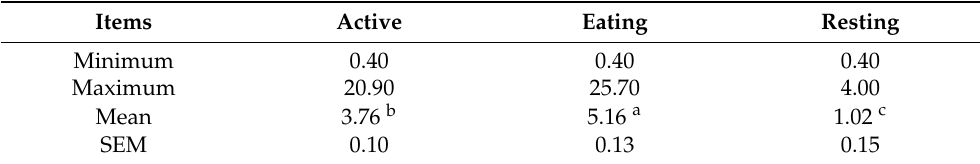
Table 2. The least-square means of the vectorial sum of the acceleration (VSA) for active, eating, and resting behaviors of the Korean